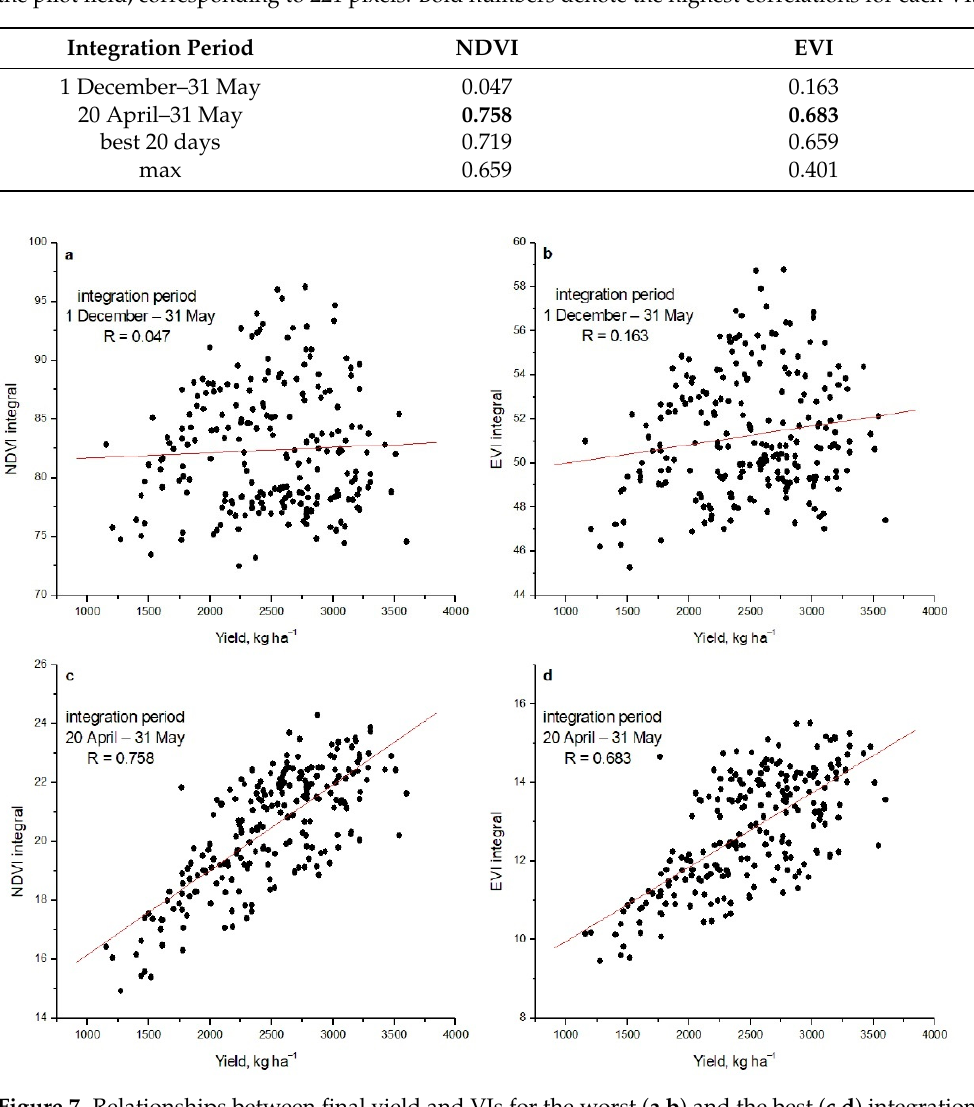
Figure 7. Relationships between final yield and VIs for the worst ( a , b ) and the best ( c , d ) integration periods. Data concern pilot field, corresponding to 221 pixels